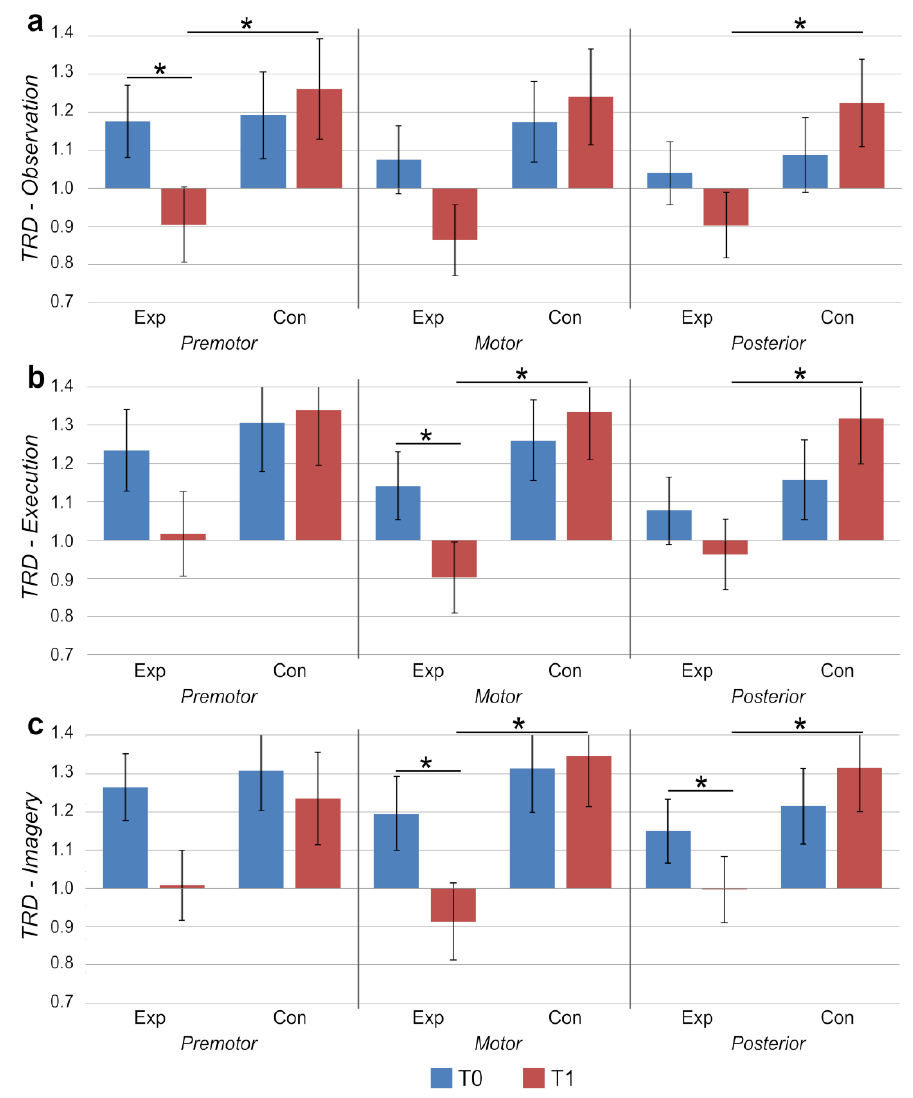
Figure 1. Task-related desynchronization (TRD) of the mu EEG band in correspondence to premotor, motor and posterior sites for the experimental (Exp) and control (Con) groups during: ( a ) action observation, ( b ) action execution, and ( c ) action imagery. T0: pre-training, T1: post-training. Bars represent group average ± 1 SE. Stars mark statistically significant pair-wise comparisons.